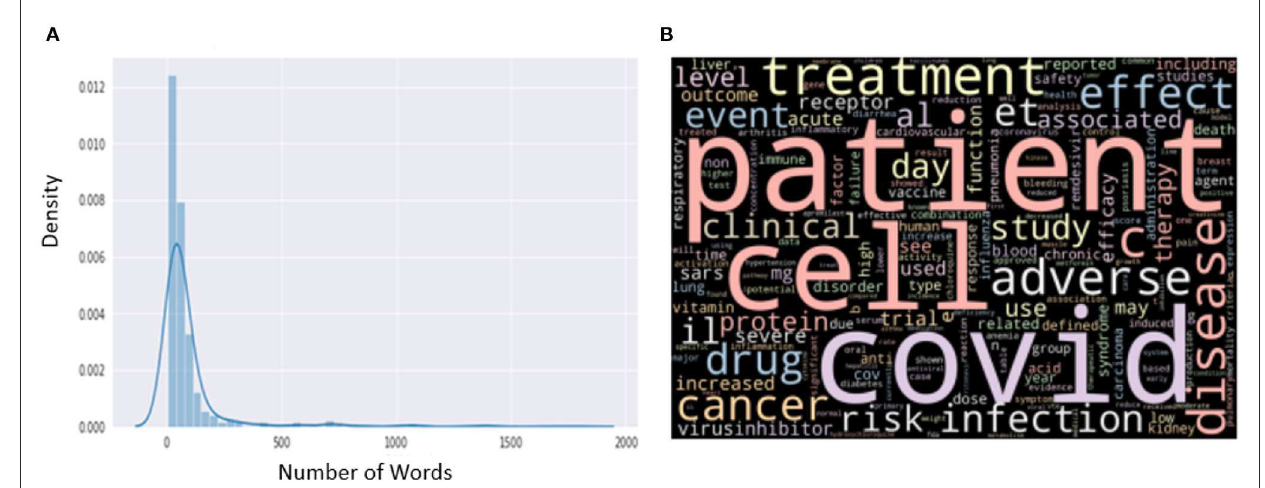
FIGURE1 (A) Distribution of length from the manually annotated sentences. (B) Word cloud from the manually annotated